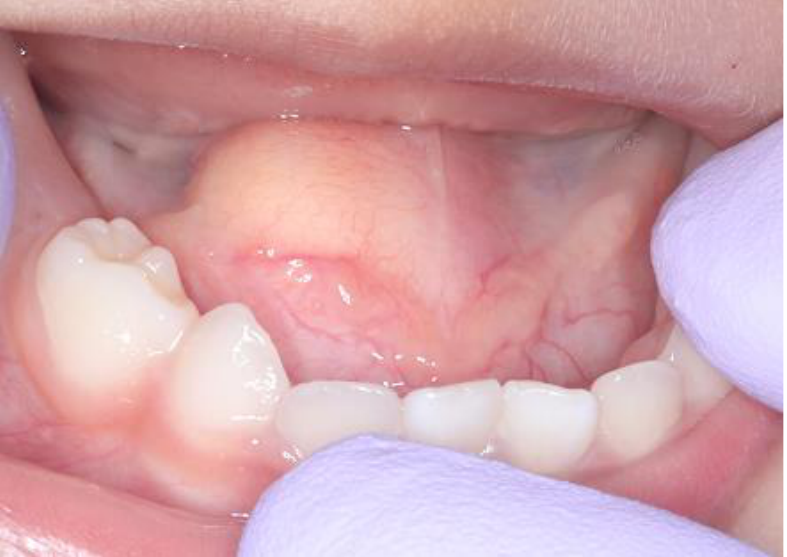
Figure 1. Intraoral photograph obtained at initial visit.